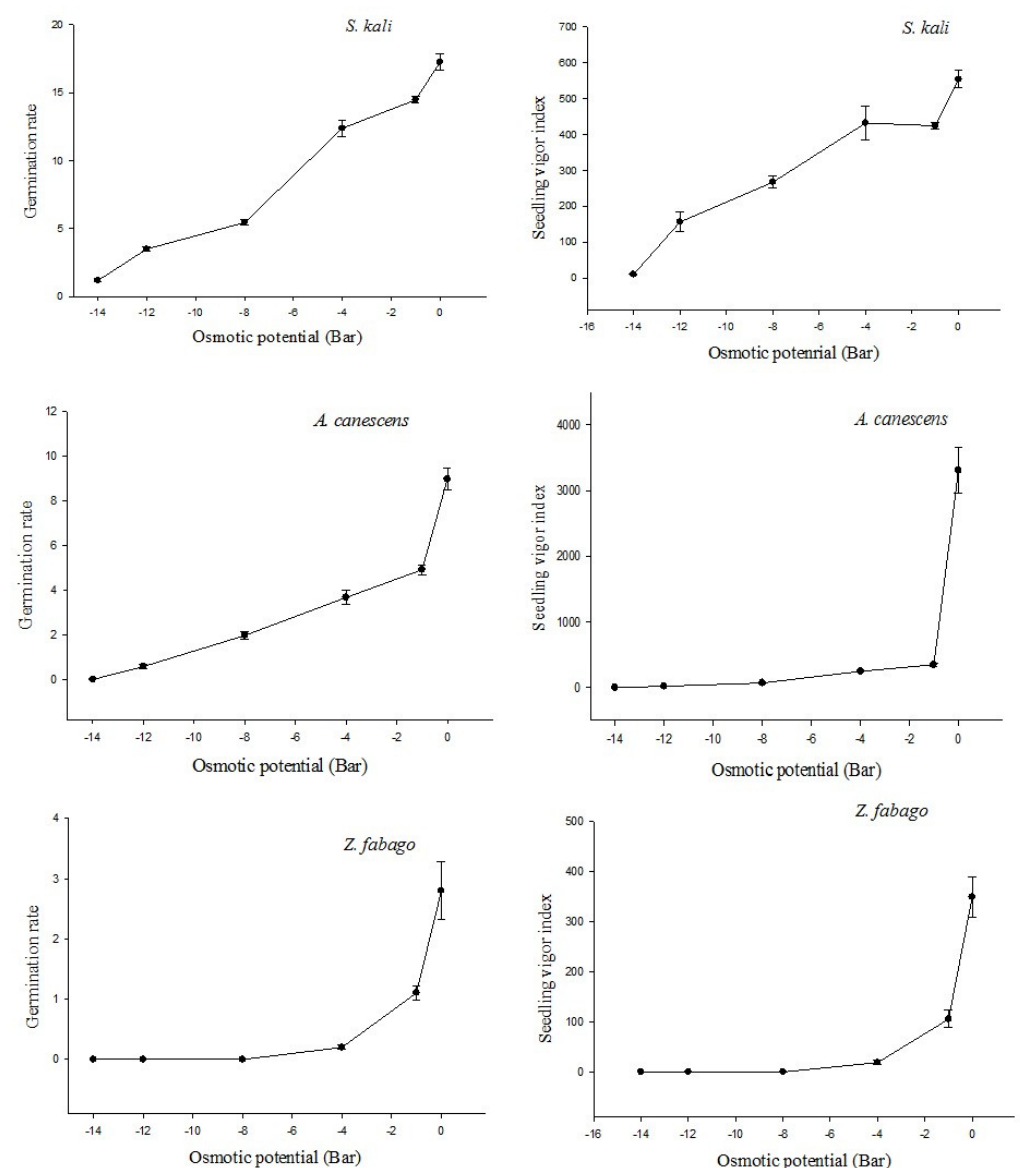
Figure 2. Germination rate ( left ) and seedling vigor index ( right ) of S. kali , A. canescens and Z. fabago under different PEG-6000 concentrations. Data represent means ( n = 4) ± SE.